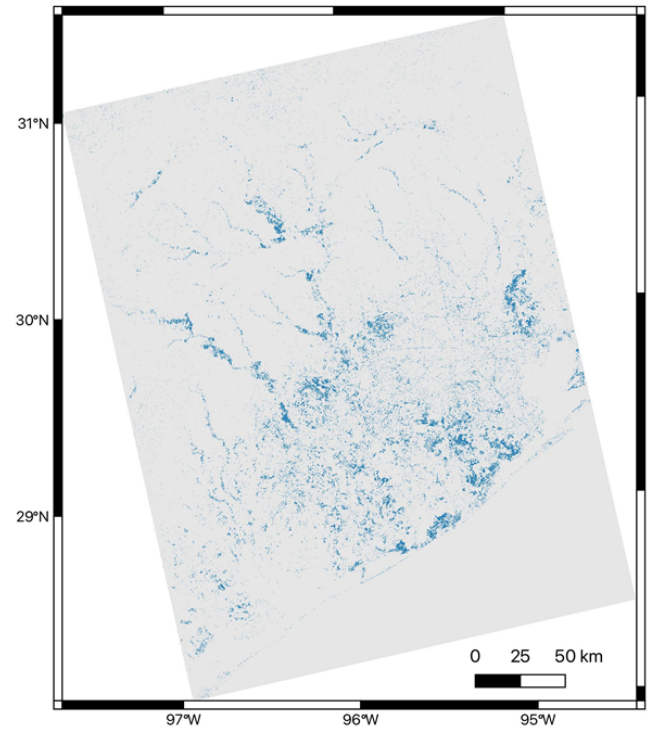
Figure 7. Results from thresholding analysis of SAR GRD data, 29 August 2017, where flood waters are detected using the thresholding method described in Thresholding. Water is shown in blue and pixel spacing is 10 m, and permanent water bodies removed using the GWM. Figure 8 shows the results from applying DeepLavv3+ ML analysis to the SAR GRD data, 29 August 2017, shown in Figure 6a. We also applied the ML analysis, DeepLabv3+, separately, to the RGB data from Figure 5b. The results are shown in Figure 9. The DeepLavb3+ analysis of the SAR GRD data, Figure 8, identifies more, smaller scale fea- tures in the data, while the DeepLavb3+ analysis of the false color RGB data identifies the most water pixels, particularly in the southern half of the image closest to the coast.